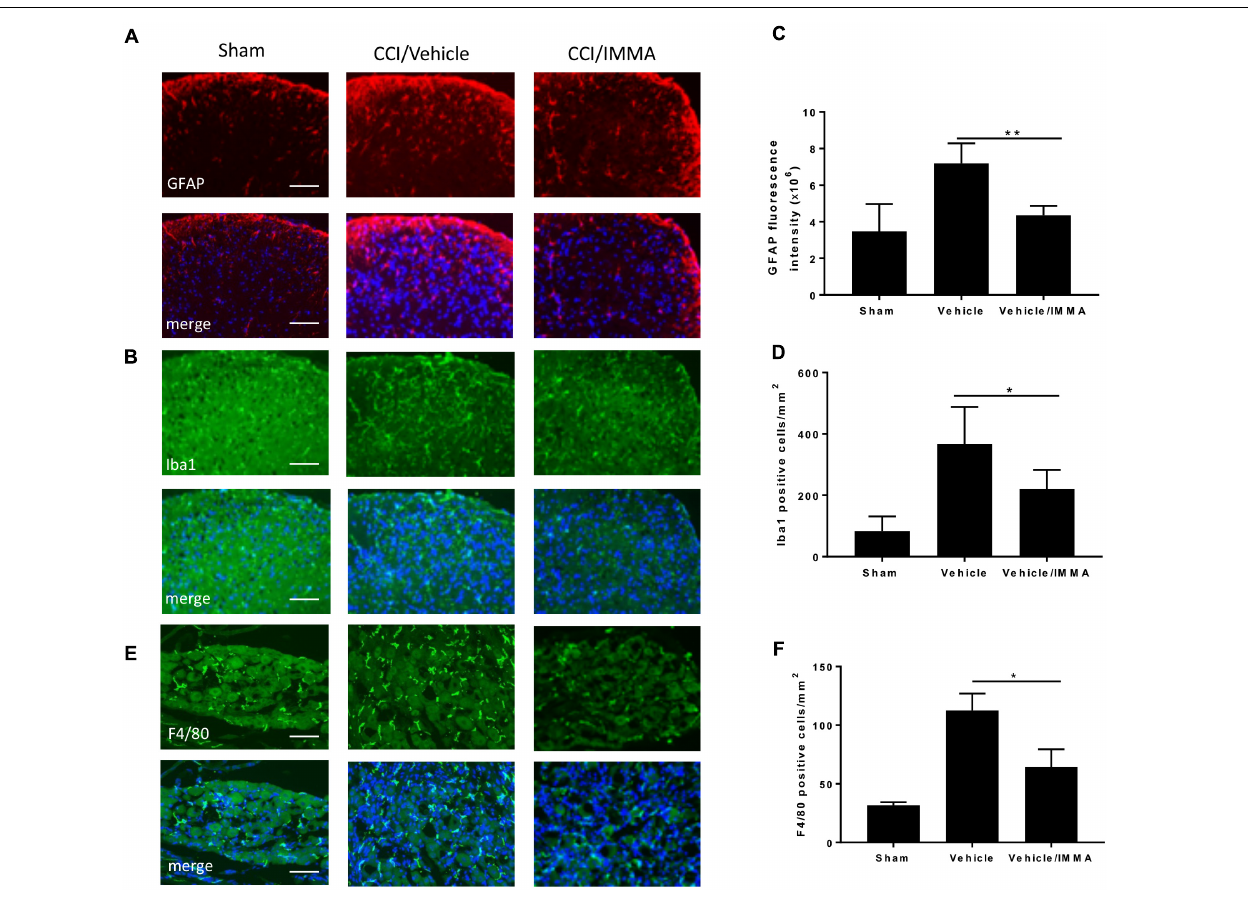
FIGURE 3 | Accumulation of inflammatory cells in CCI mouse spinal cord dorsal horn and DRG was reduced by IMMA treatment. The numbers of GFAP and Iba1 positive cells in ipsilateral lumbar spinal cord dorsal horn (A,B) and F4/80 positive staining in ipsilateral DRG (E) in IMMA treated group were remarkably reduced compared to the CCI/vehicle group. Quantitation of the GFAP and Ibal positive cells in spinal cord dorsal horn and F4/80 positive cells in DRG were shown in C,D,F ( ∗ p < 0.05 and ∗∗ p < 0.01, n = 10/group). One-way ANOVA was used for quantifying the differences in GFAP, Iba1, and F4/80 staining among the sham, vehicle and IMMA treated groups (C,D,F) . The Tukey-Kramer post hoc test was used for all the comparison. The merged images in A,B,E showed the co-localization of DAPI (blue) with GFAP (red), Iba1 (green), and F4/80 (green). Scale bar = 250 µ